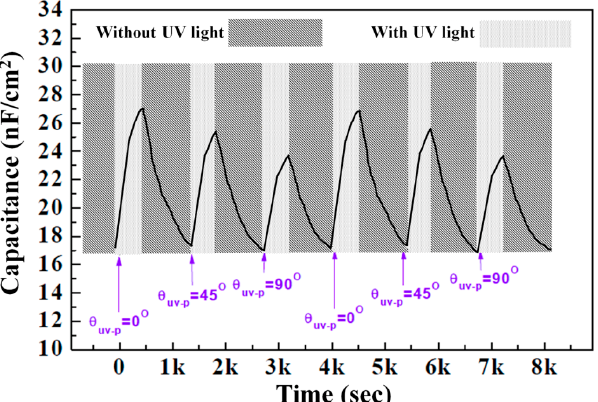
Figure 9. Electrical measurement of UV polarization with the guest-host film. Repetitive and reversible capacitance variation of photochromic guest-host films with the MIM structure measured by changing θ UV-P of the UV irradiation.